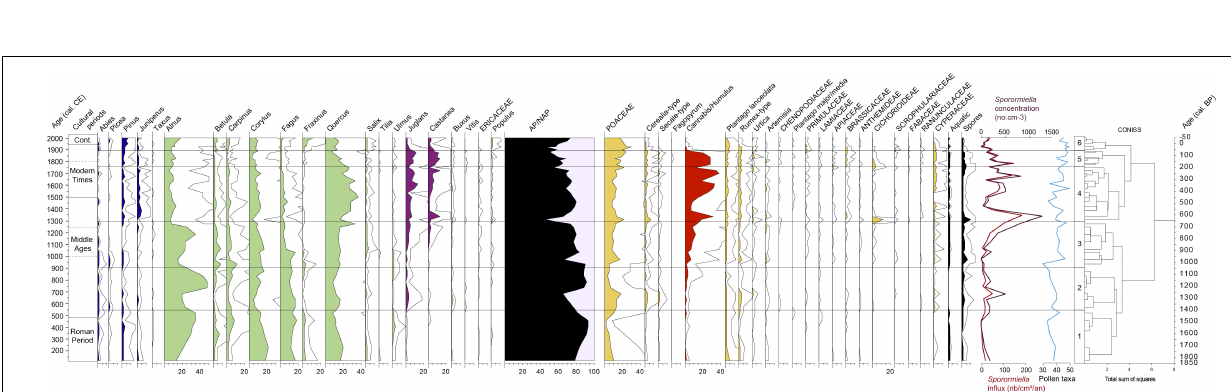
FIGURE 6 | Pollen diagram from core AIG 16-MC presented as a percentage of the pollen sum. + Sporormiella sp. concentrations and accumulation rates. The exaggeration curves are x5.